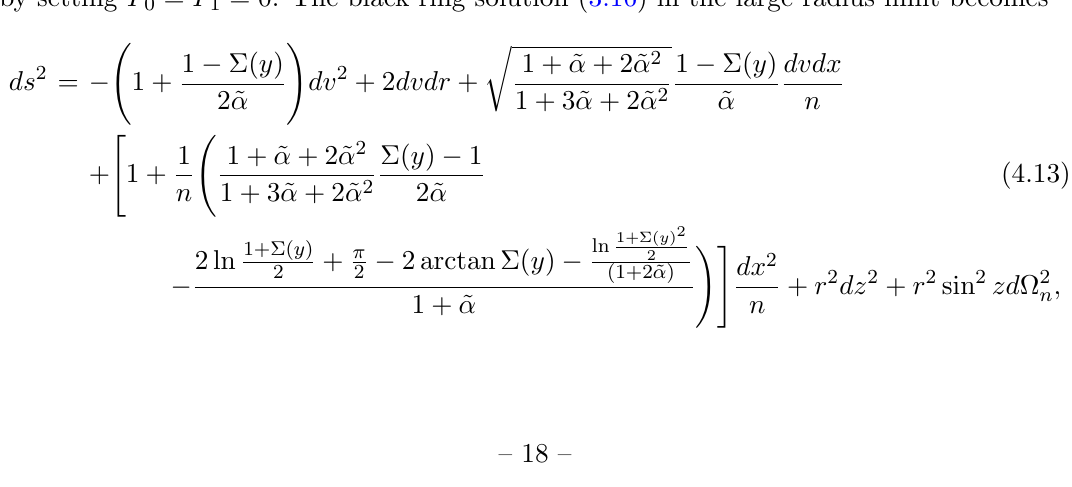
black rings in the Einstein gravity [25] and the Einstein-Maxwell theory [33], the frequencies for the axisymmetric QNMs are the same as the ones of the large D Schwarzschild and Reissner-Nordstrom black holes up to a multiplicative factor characterizing the (cid:12)niteness of the ring. However, it is easy to see that for the EGB black ring this does not hold any more. This is because unlike the case in the Einstein gravity, although for the m = 0 modes the perturbations do not have interaction along (cid:30) direction, from (4.1), (4.2) and (4.3) we can see that the situation is still di(cid:11)erent from the one of the D (cid:0) 1 dimensional EGB black hole. However, as we will see in the next section, for the slowly boosted EGB black string the QNMs of the axisymmetric perturbations are the same as the ones of the EGB black hole